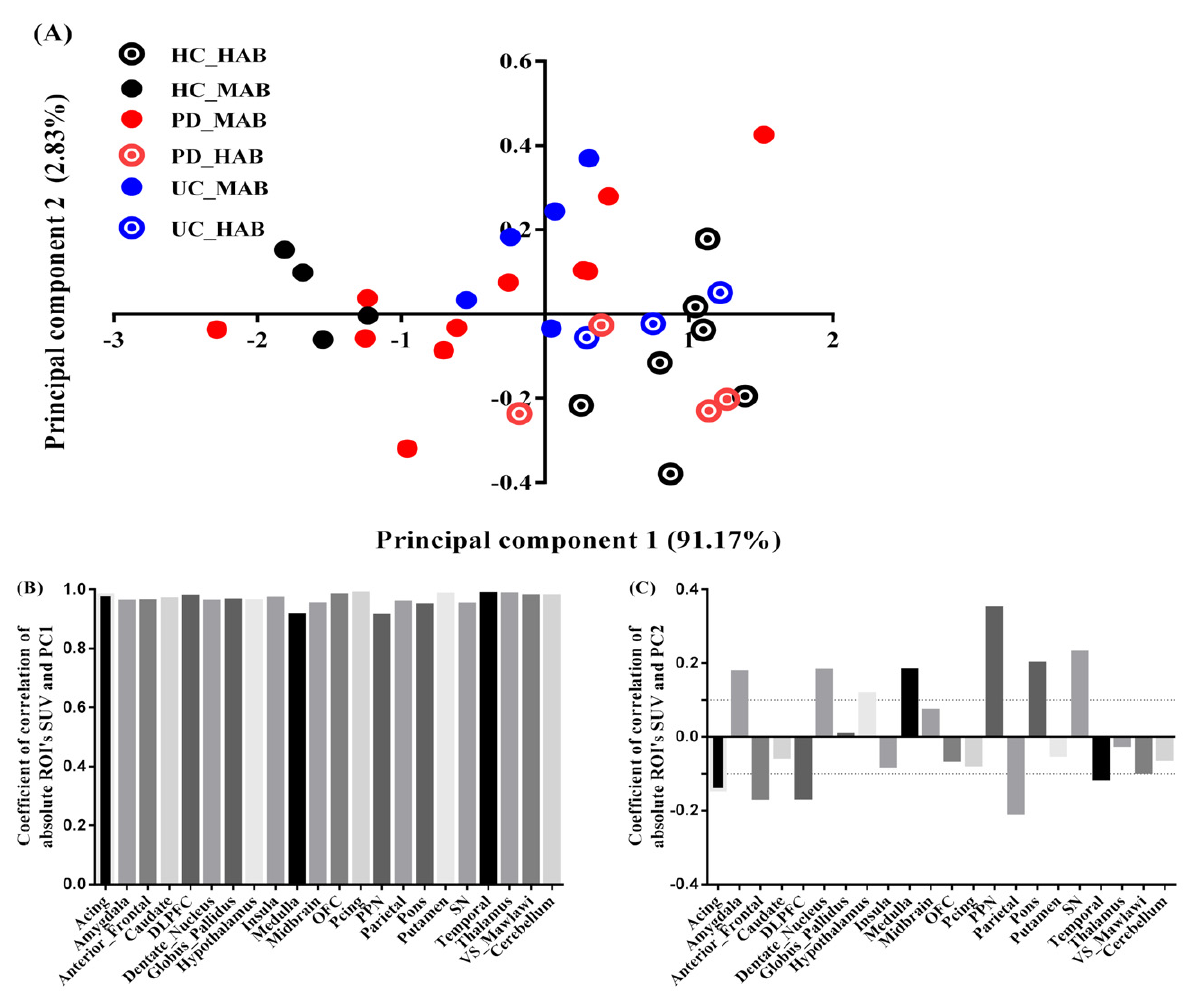
Figure 3. PCA absolute SUV characteristics. ( A ) Factor scores of the observations plotted on the first two components. PC1 explained 91% of the variance and PC2 explained 3% of the variance. ( B ) Coefficients of correlation between ROI’s SUV and PC1. ( C ) Coefficients of correlation between ROI’s SUV and